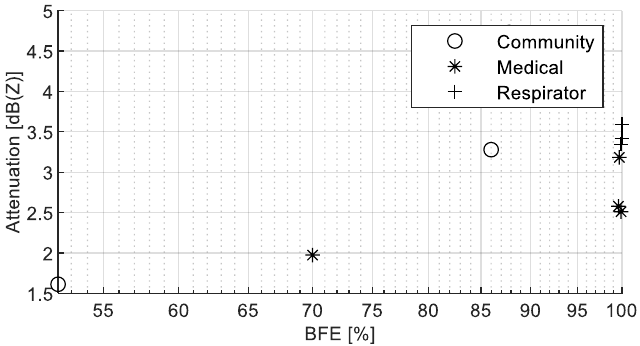
Figure 18. Correlation between acoustic attenuation and the logarithm of the